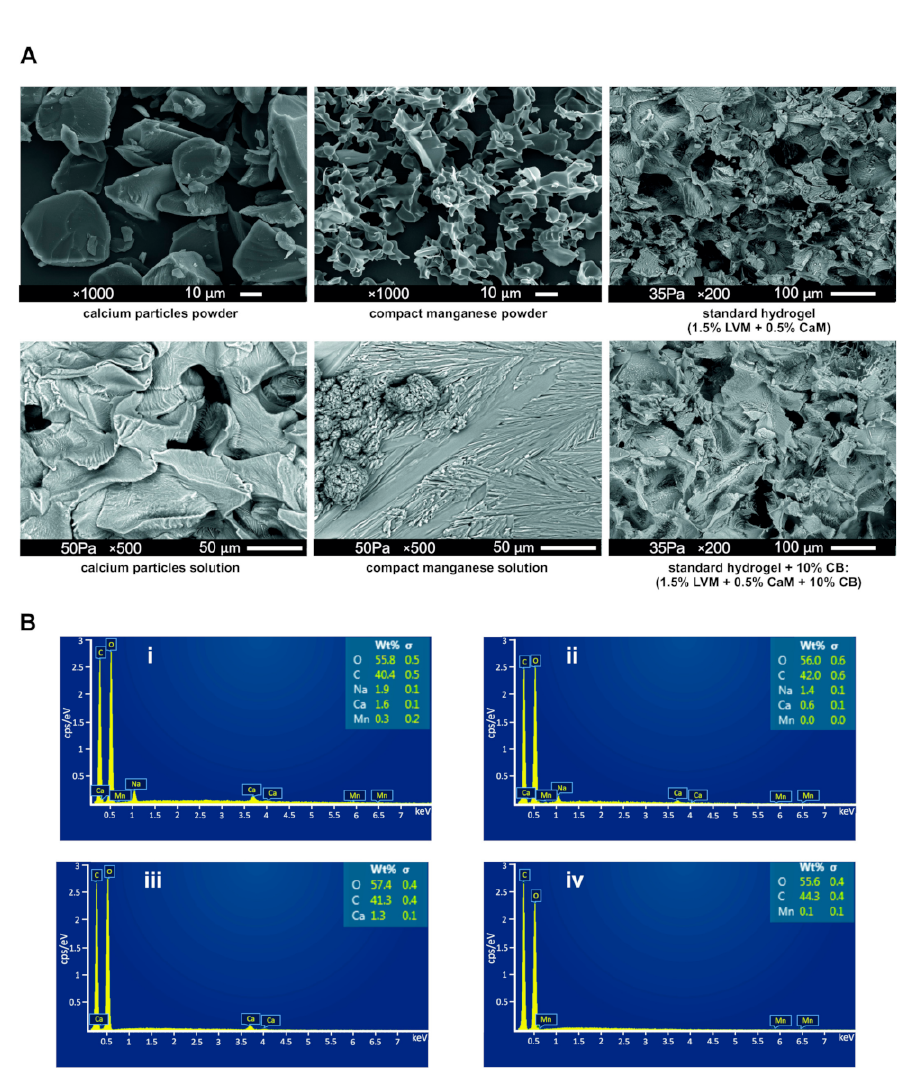
Figure 5. Characteristics of alginate hydrogels: ( A ) SEM analysis of selected hydrogel’s compounds and hydrogel combinations; and ( B ) EDS analysis presenting a chemical composition of ( i ) SD + 10% CB hydrogel; ( ii ) SD hydrogel; ( iii ) calcium alginate powder; ( iv ) compact manganese alginate particles